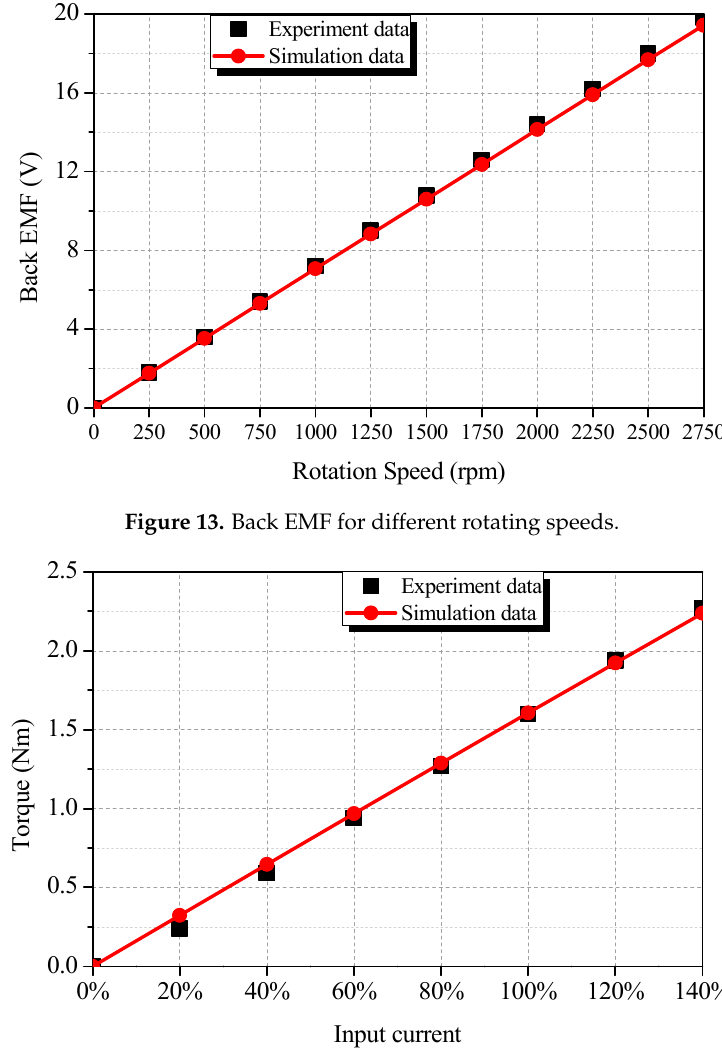
Figure 12. Experimental setup: ( a ) Human machine interface; ( b ) back-to-back system.